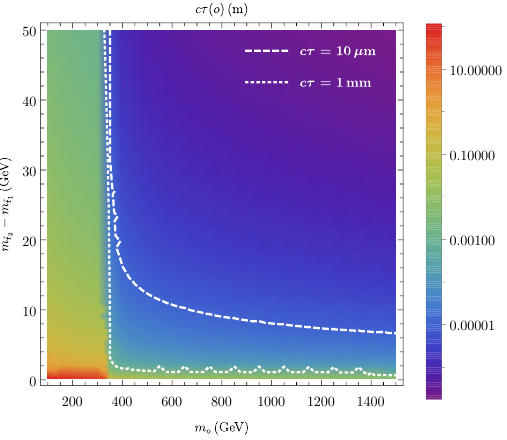
Figure 8. Characteristic traveling distance of the pseudoscalar sgluon in a modi(cid:12)ed B1 with variable stop mass